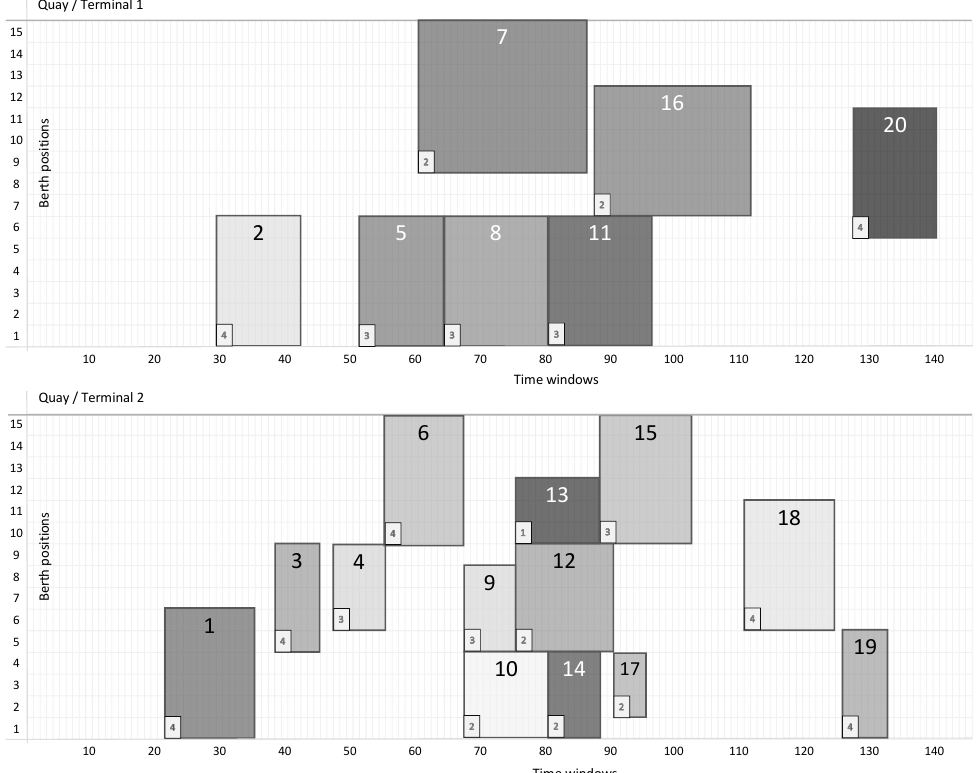
Figure 3. Graphical solution of berth allocation problem (BAP) and quay crane allocation problem (QCAP) for the multi-quay environment.